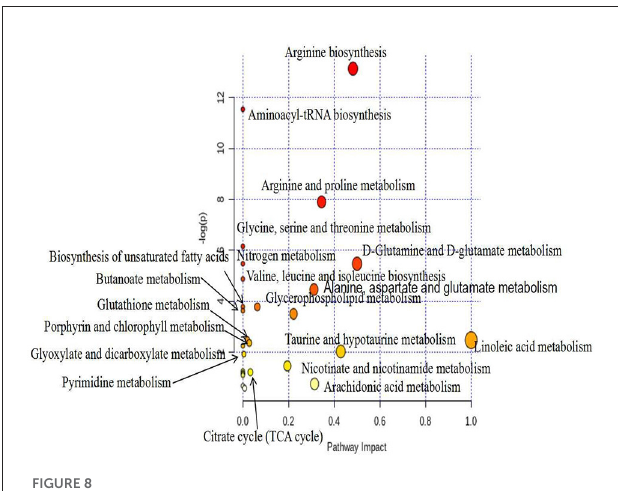
FIGURE8 Metabolic pathway analysis (positive), metabolic pathway change